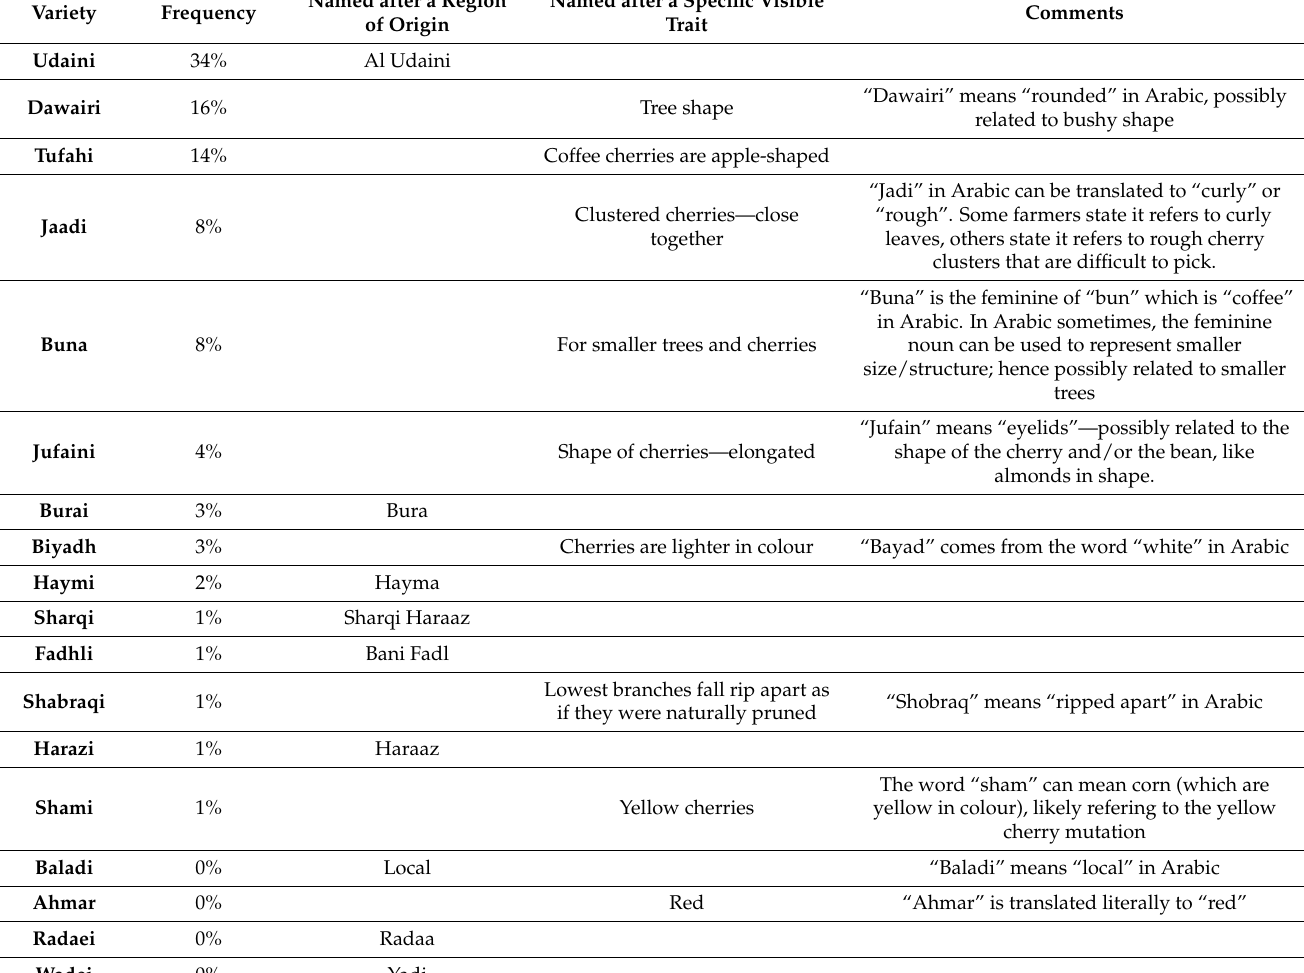
Table 3. Origin of the vernacular coffee names in